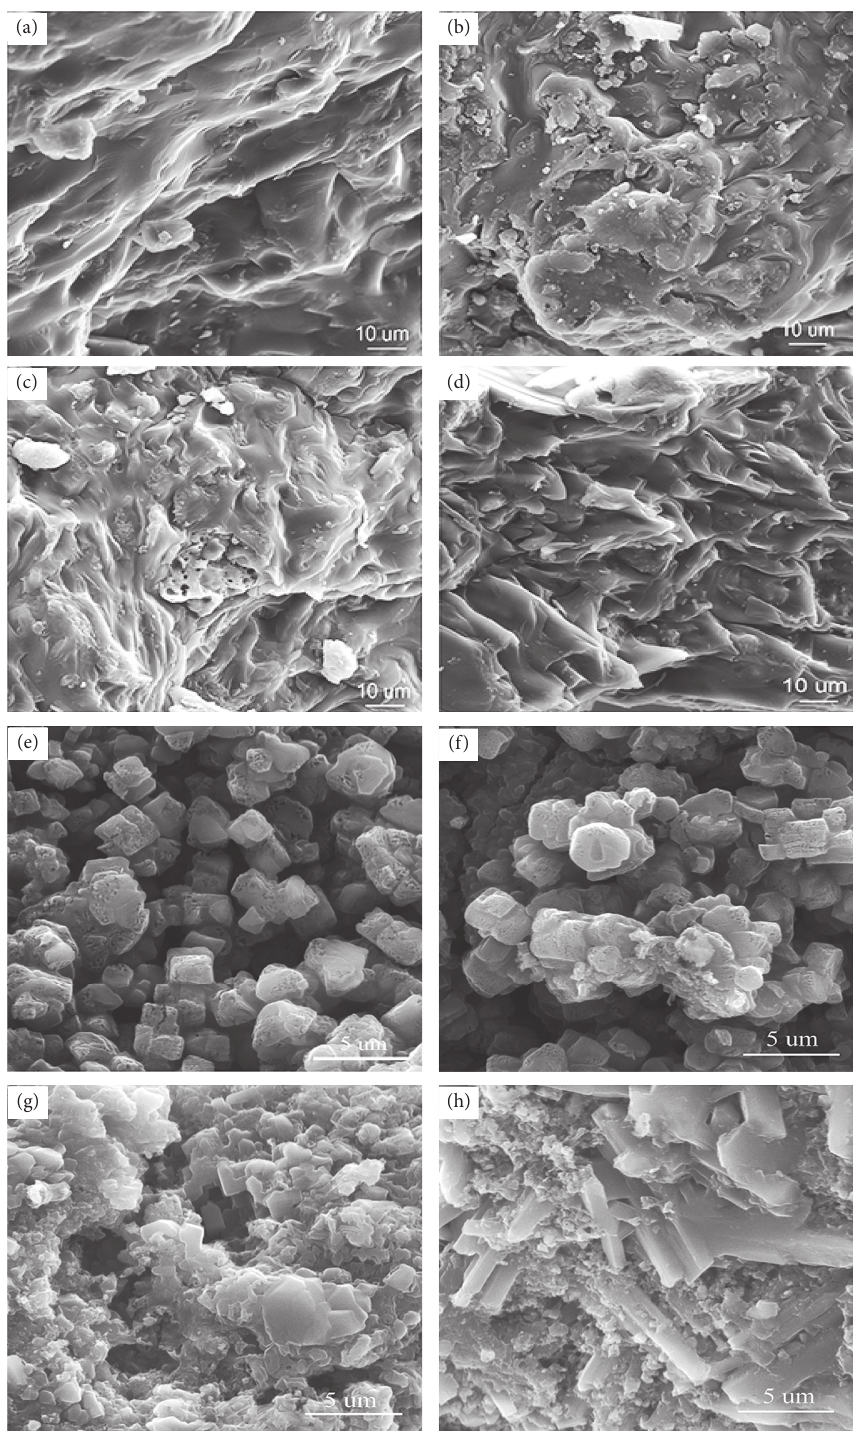
Figure 5: Effect of the heat treatment temperature on the morphology of parent CTP and MM-8-1. (a) Parent CTP-500; (b) parent CTP-600; (c) parent CTP-700; (d) parent CTP-800; (e) MM-8-1-500; (f) MM-8-1-600; (g) MM-8-1-700; (h)